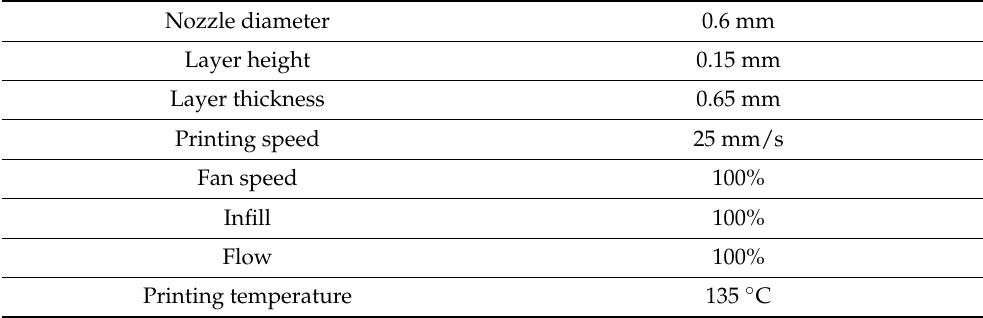
Table 1. Filament printing